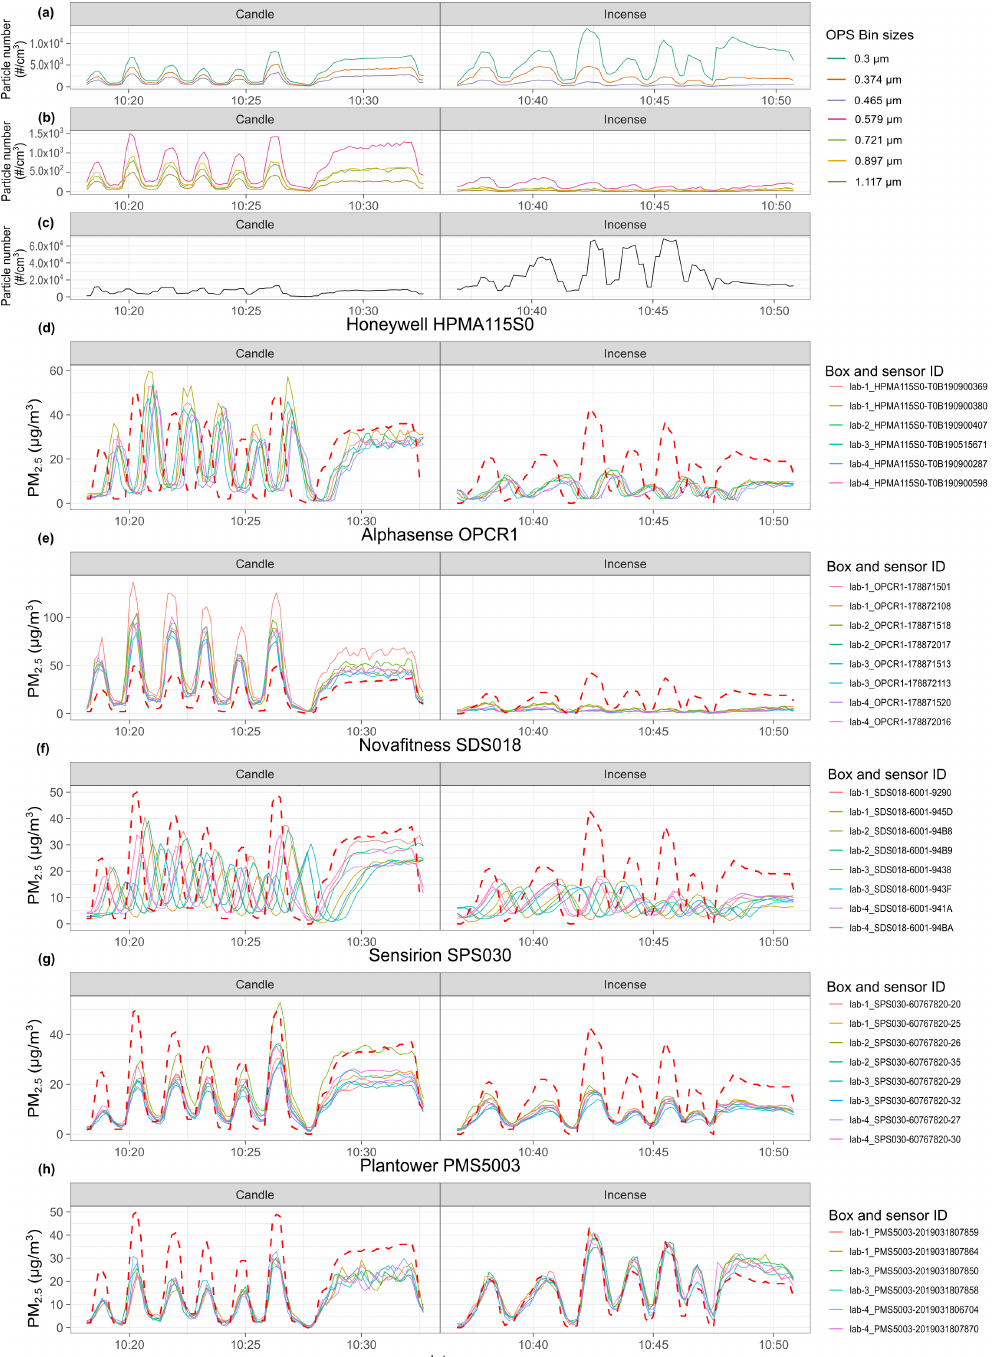
Figure A11. Time series of experiment 3. From top to bottom: ( a , b ) TSI 3330 OPS Bin size distribution; ( c ) Nanotracer ultrafine particles number concentration #1/cm 3 ; ( d – h ) PM 2.5 of the sensors for each model of sensor, against DustTrak (red dotted line). The sensors are named according to the box they are placed in and their serial